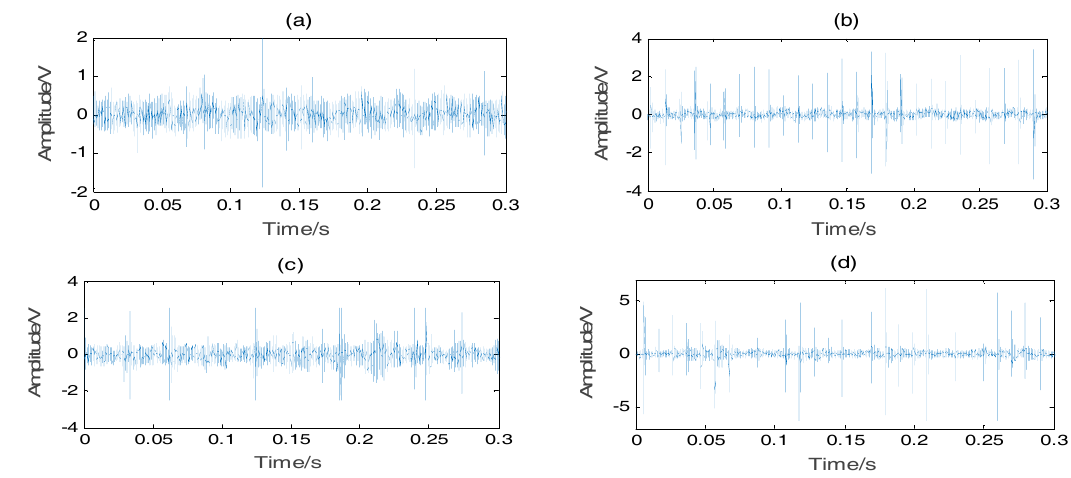
Figure 8. Vibration signal in each state: ( a ) normal; ( b ) outer ring defect; ( c ) inner ring defect; and ( d ) rolling element defect. Table 1. Bearing parameters for verification.